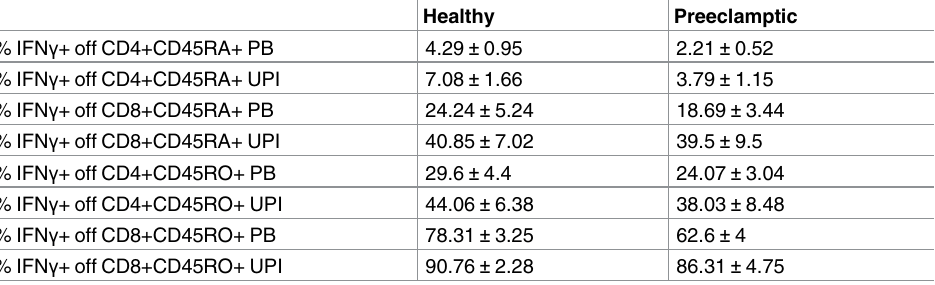
Table 8. Mean percentage +/- SEM IFN γ + CD4 or CD8+ T cells gated off total CD4+ or CD8+ T cells in PB and at the UPI of healthy and preeclamptic (PE) patients, see also Fig